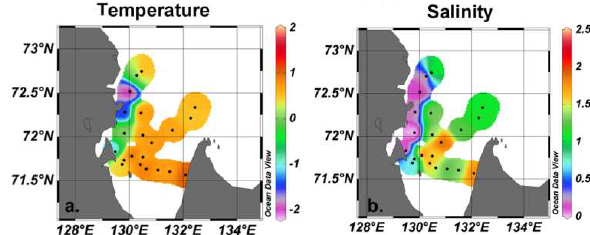
Fig. 4. ODV surface plots summarizing the stratification strength with respect to (a) temperature ( ◦ C) and (b) salinity at each station in the coastal transects (T1–T4). The figure is based on the stratifi- cation indices calculated for temperature and